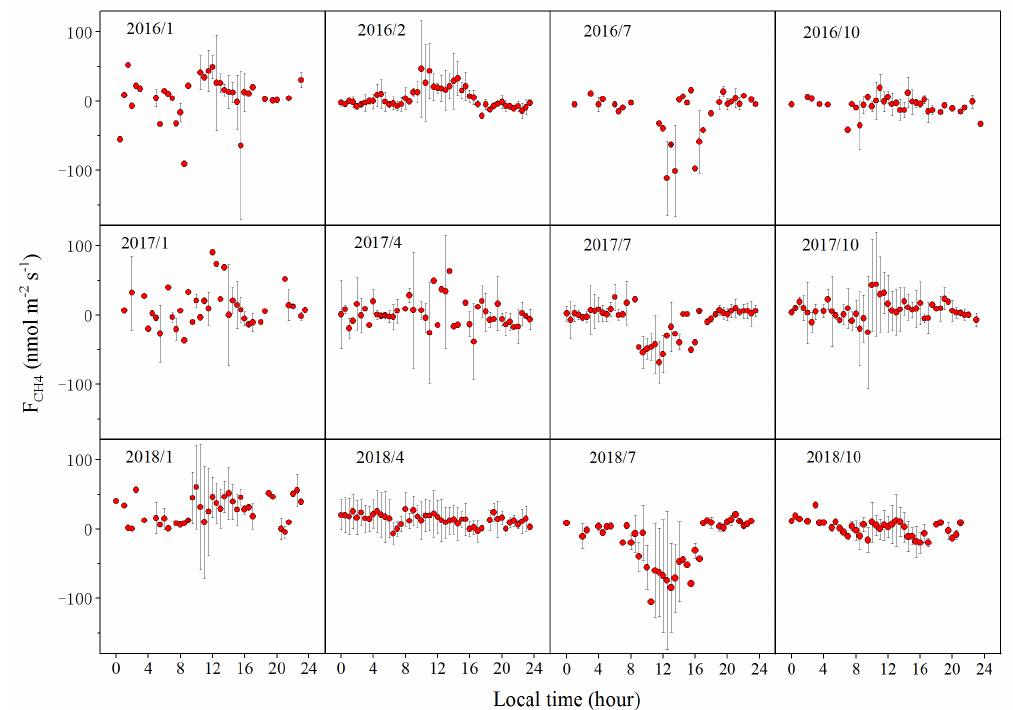
Figure 3. The diurnal pattern of ecosystem-scale CH 4 flux from the subtropical forest in different seasons during 2016–2018. The red points show the average half-hourly flux at the same time in the month. January, April, July and October of each year represent the four seasons of spring, summer, autumn and winter. The data in February were used for spring 2016, as data from March to June were missing due to a lack of electrical power supply.